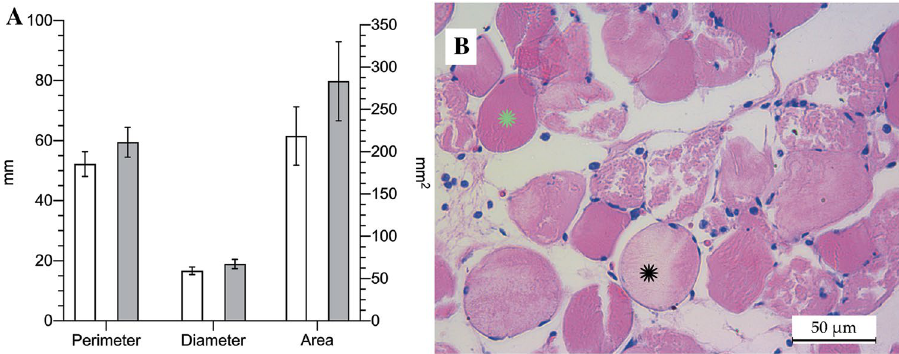
Figure 3. Upper-thigh girth and cross-sectional area of the legs exposed to 3 h of ischemia and 24 h of reperfusion (grey) and the other legs, used as healthy controls (white). Girth and cross-sectional area are expressed in millimetres (mm, left axis) and millimetres squared (mm 2 , right axis), respectively ( A ). Representative histological section of a limb subjected to ischemia–reperfusion (the green asterisk indicates an undamaged muscle fibber and the black asterisk shows a muscle fibber damaged by ischemia–reperfusion. The extensive polymorphonuclear cell infiltrate (stained in blue) and oedema between the muscle fibbers (white space) are also seen) ( B ).